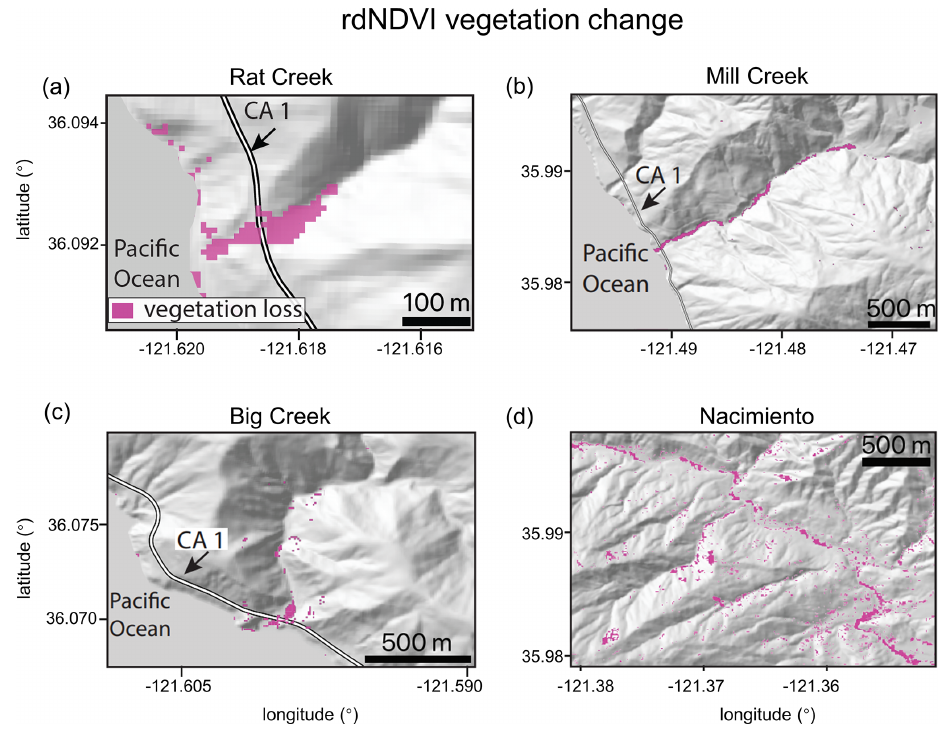
Figure 3. Identified debris flow sites using rdNDVI vegetation change within the Dolan burn scar. We convert the rdNDVI data into a binary map by setting a threshold value, which yields only the likely debris flow locations. We then drape these maps over a topographic hillshade. (a) – (d) Sentinel-2 rdNDVI vegetation change at (a) Rat Creek, (b) Mill Creek, (c) Big Creek, and (d) the Nacimiento River.